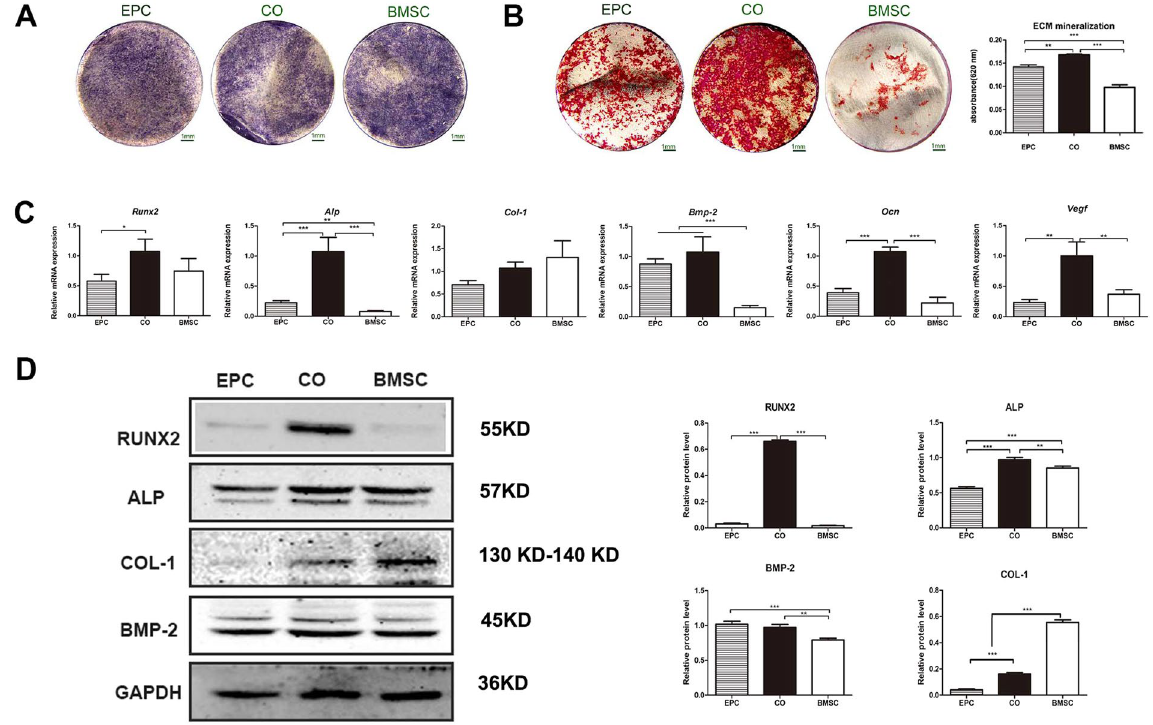
Figure 3. ( A ) ALP staining. ( B ) ECM mineralization and the quantitative colorimetric results of ECM mineralization. ( C ) Gene expression of Runx2 , Alp , Col-1 , Bmp-2 , Ocn and Vegf . ( D ) Western blot analysis of RUNX2, ALP, COL-1, BMP-2 and GAPDH. The graphs show the semi-quantitative analysis of the results relative to GAPDH. ( * p < 0.05, ** p < 0.01, *** p <